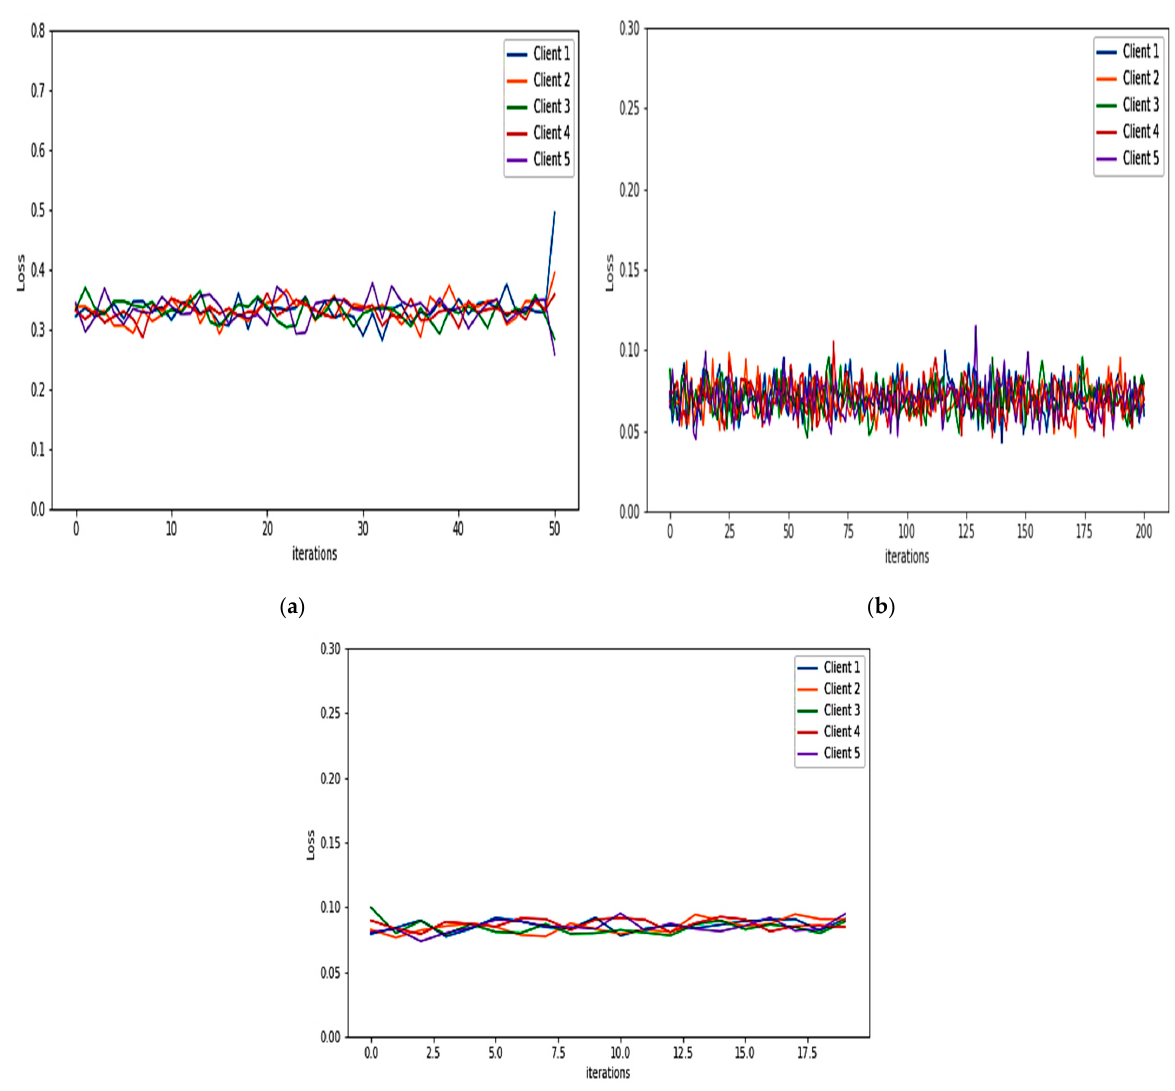
Figure 11. Losses in testing for each client of the proposed algorithm using: ( a ) CSE-CIC-IDS2018; ( b ) Bot Net IoT; and ( c ) KDD Cup 99. ( b ) Bot Net IoT; and ( c ) KDD Cup